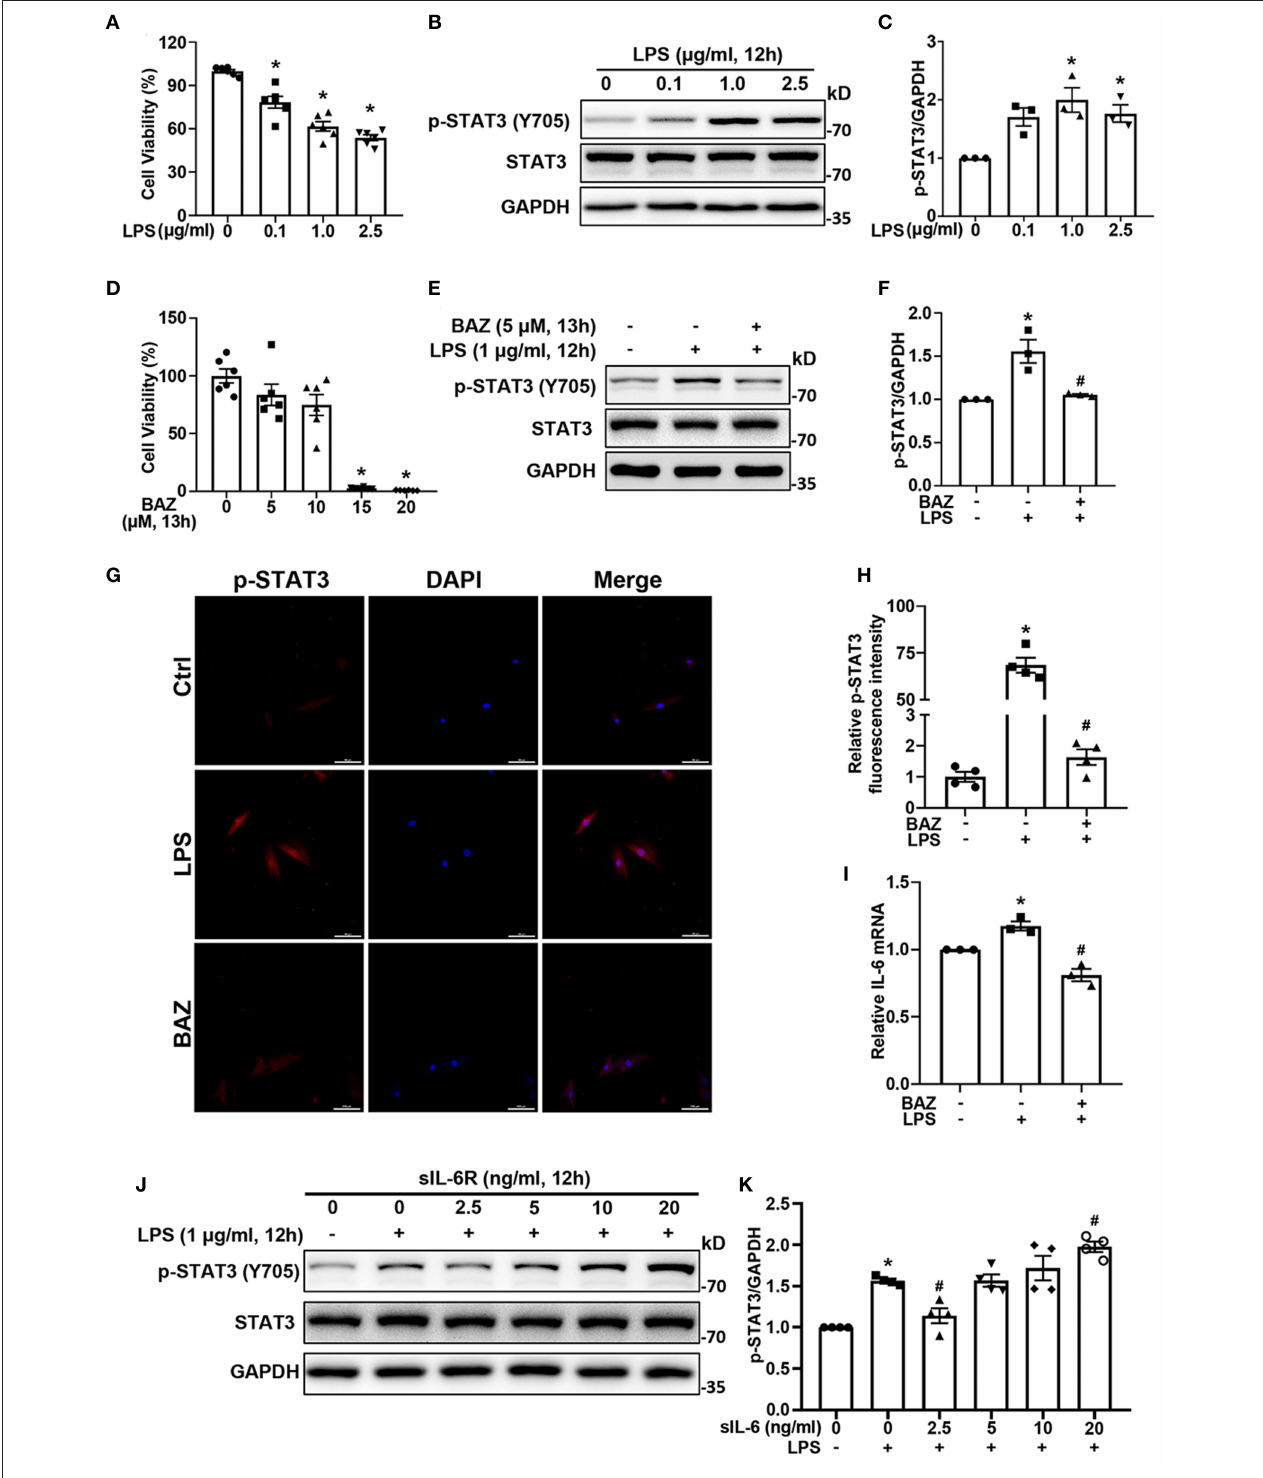
FIGURE 3 | Bazedoxifene inhibited IL-6/STAT3 signaling induced by LPS in H9c2 cells. (A) Cell viability of H9c2 cells after treatment of various concentrations LPS for 12h. (B) The corresponding STAT3 activation was determined by western blot analysis. (C) Quantitative analysis of western blot. (D) Cell viability of H9c2 cells after treatment of various concentrations Bazedoxifene for 13h. (E,F) : For LPS stimuli, H9c2 cells were treated with LPS (1 µ g/ml) for 12h. For Bazedoxifene treatment,